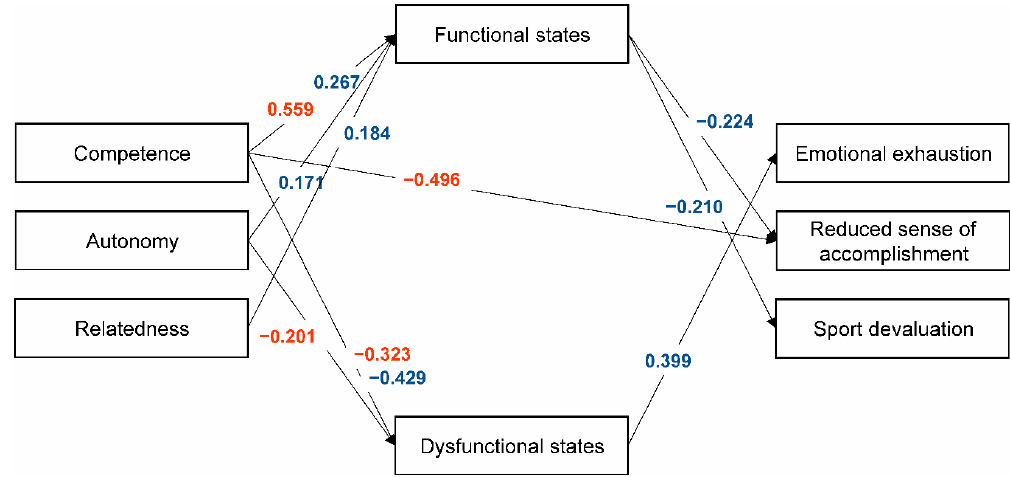
Figure 2. Path analysis results for the data of 16–18-year-olds. Only significant standardized estimates are presented ( p < 0.05) for girls (red) and boys (blue).